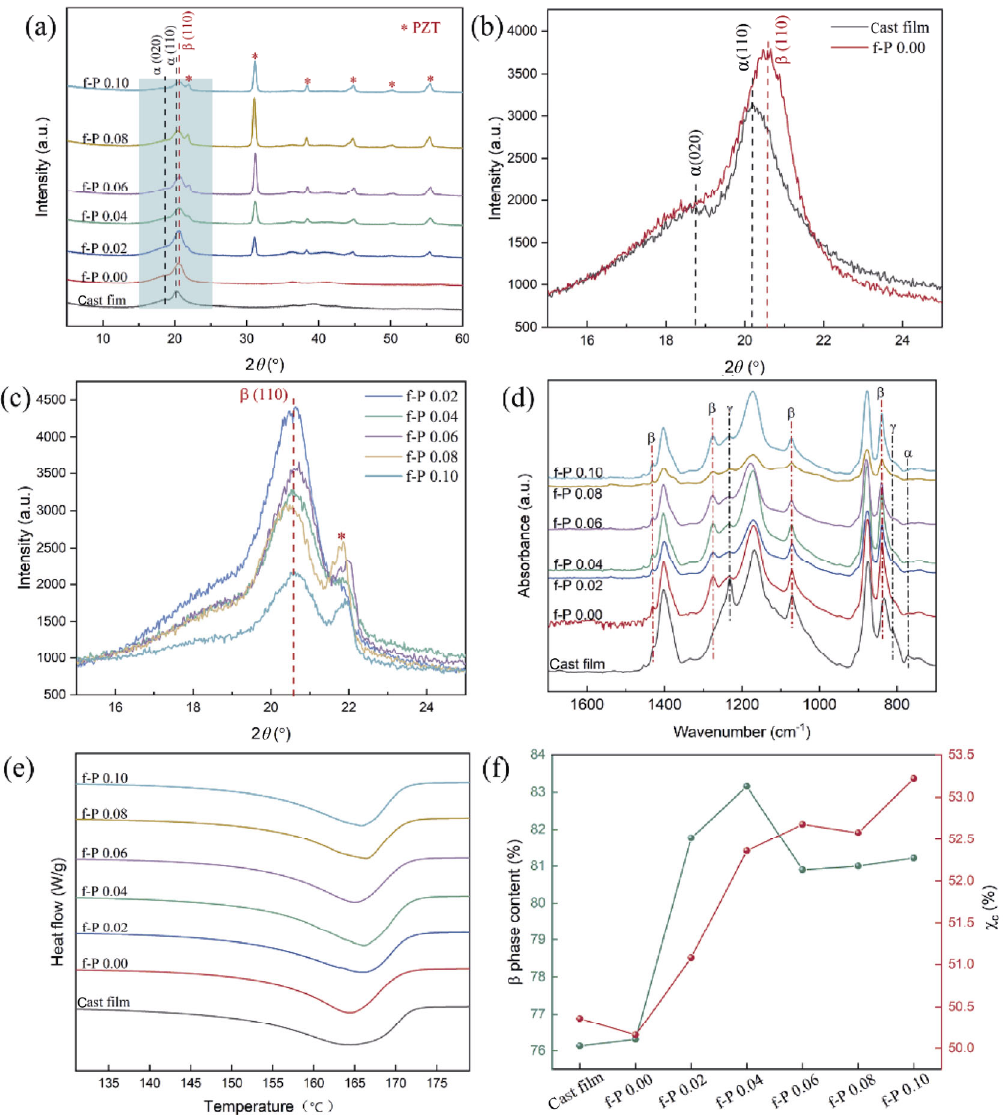
Fig. 4 (a) XRD patterns, (d) FTIR spectra in ATR mode, (e) DSC curves, and (f) the calculated crystallinity degree and β phase content of pure PVDF cast film and PZT/PVDF fiber films with different PZT concentrations. Enlarged XRD view of (b) PVDF cast film and PVDF fiber film and (c) PZT/PVDF composite fiber films from 15° to 25°.